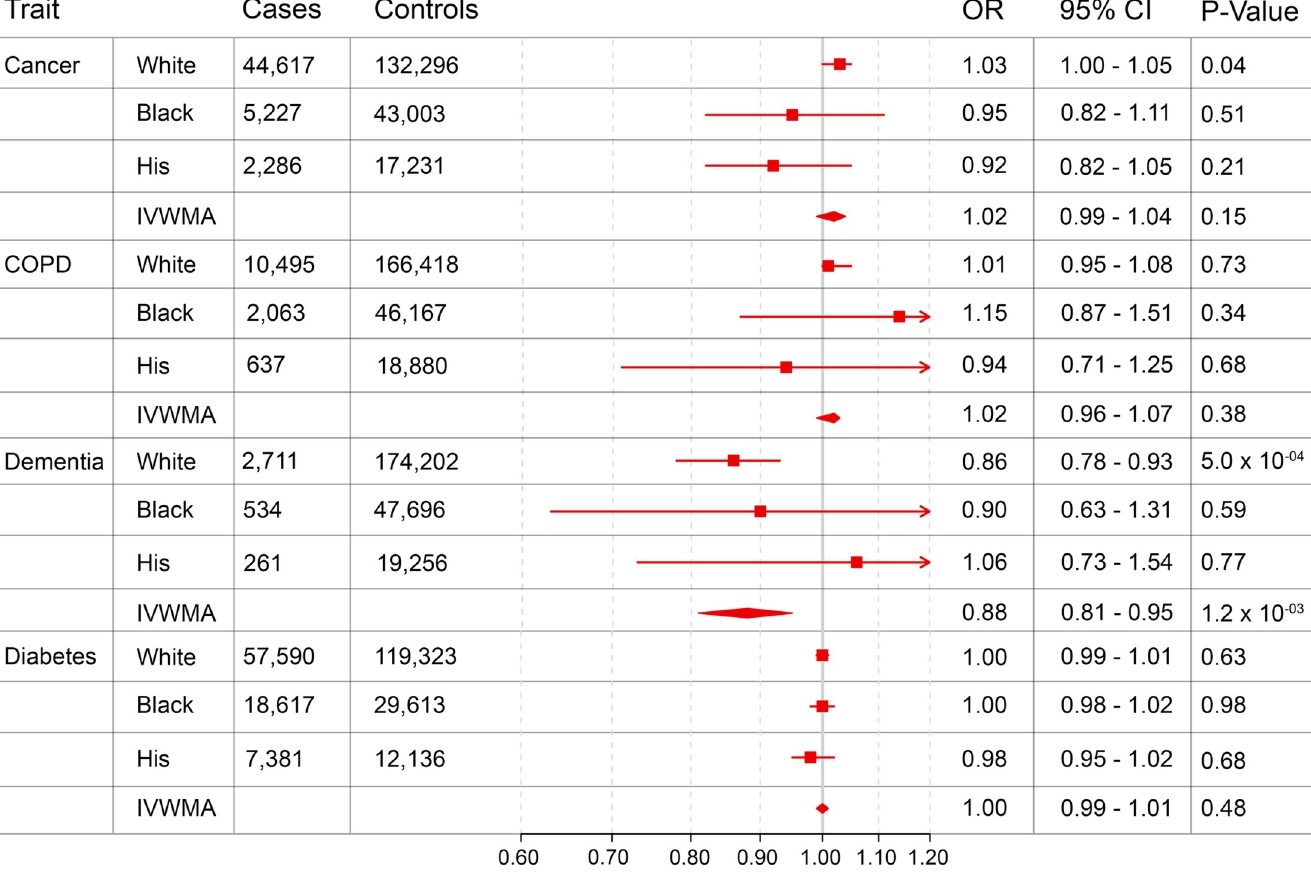
Fig 3. Weighted odds ratios reflecting the impact of a genetically determined 10 mg/dL decrease in LDL-C on safety and efficacy endpoints. Odds ratio and 95% confidence interval is displayed for the effect of a genetically determined 10 mg/dL decrease in LDL-C on safety and efficacy endpoints for White individuals, Black individuals, Hispanic individuals, and inverse variance weighted meta-analysis of White, Black, and Hispanic populations (IVWMA). All analyses were performed controlling for age, sex, and 5 ancestry-specific principal components.